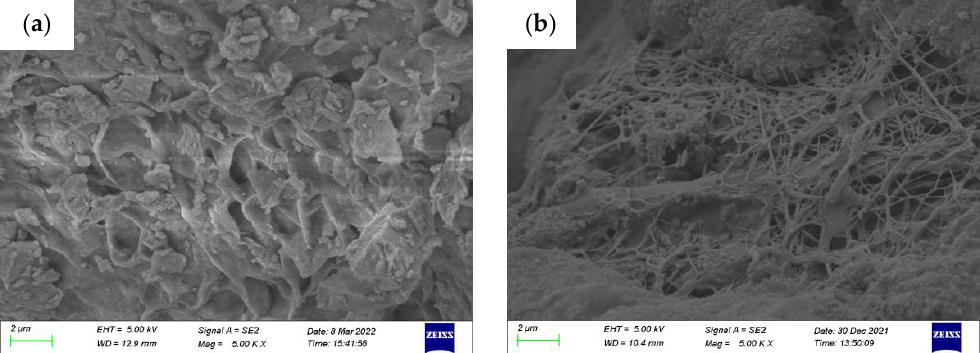
Figure 9. SEM of modified PS samples. ( a ) Sample based on CaCl 2 , ( b ) sample based on AlCl 3.